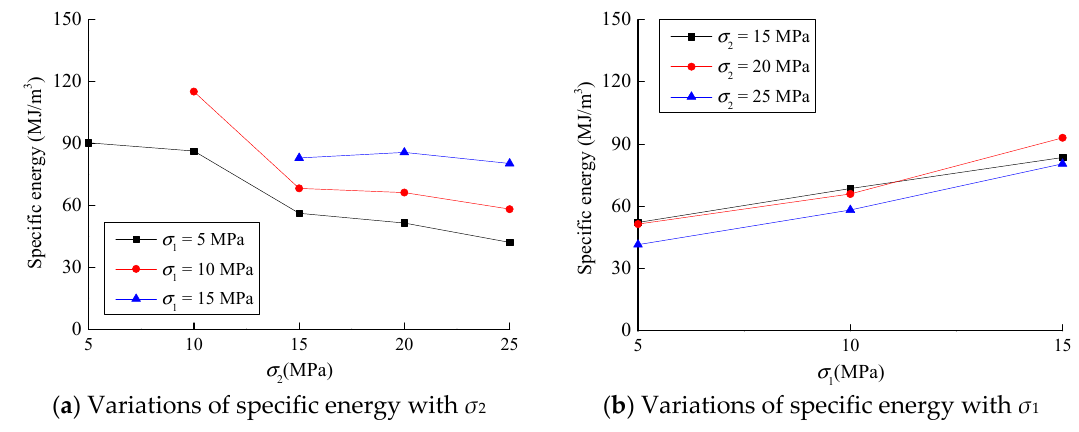
Figure 12. Specific energy efficiency under different confining pressures.